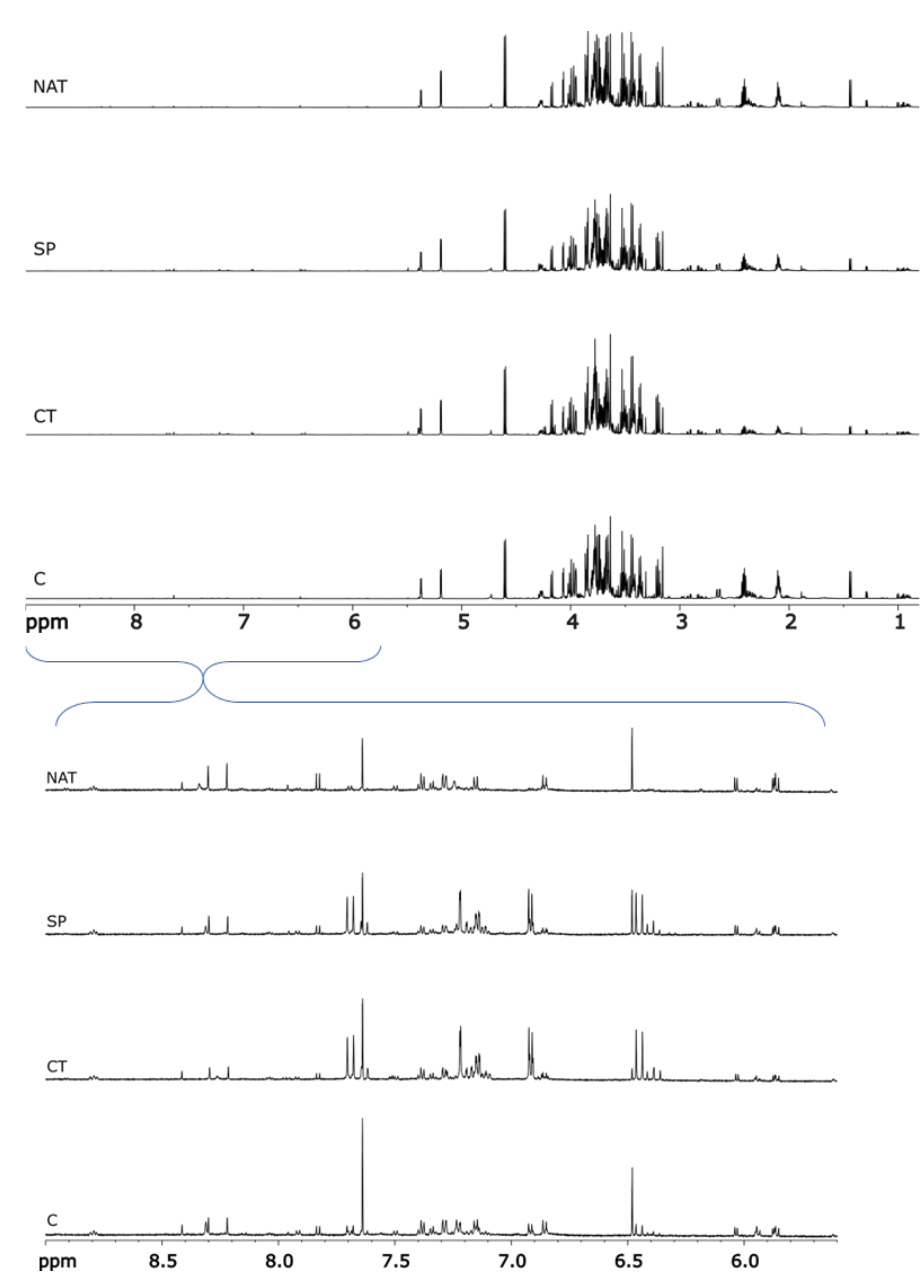
Figure 3. Full 1 H NMR spectra in deuterium oxide (D 2 O) at 600 MHz of L. sativa leaf extracts of the control plant (C) and the three treatments (CT, SP and NAT). Only one of the three replicates is shown for each treatment ( Top ), all replicates are reported in Figure S1. Expanded high field region of the 1 H NMR spectra ( Bottom ).